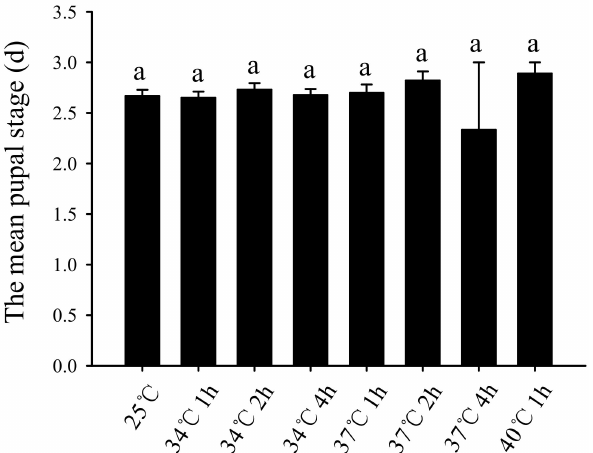
Figure 2. E ff ect of short-term high-temperature stress on the average pupal stage of Bradysia odoriphaga third-instar larvae after pupation ((d) = days). Values are means ± SD of five replicates. Within each panel, bars with same letters are not significantly di ff erent according to Tukey’s test ( p > 0.05). Each pupa of per replicate was put into a separate Petri dish and was marked. The change of pupae was monitored daily. The pupal period is the time between pupation and eclosion. Pupae without the capability of eclosion are not included. The total numbers (N) of pupae with the capable of eclosion were 264, 252, 253, 248, 213, 156, 13, and 36 after third-instar larvae exposure to 25 ◦ C or 34 ◦ C for 1 h, 34 ◦ C for 2 h, 34 ◦ C for 4 h, 37 ◦ C for 1 h, 37 ◦ C for 2 h, 37 ◦ C for 4 h, and 40 ◦ C for 1 h,